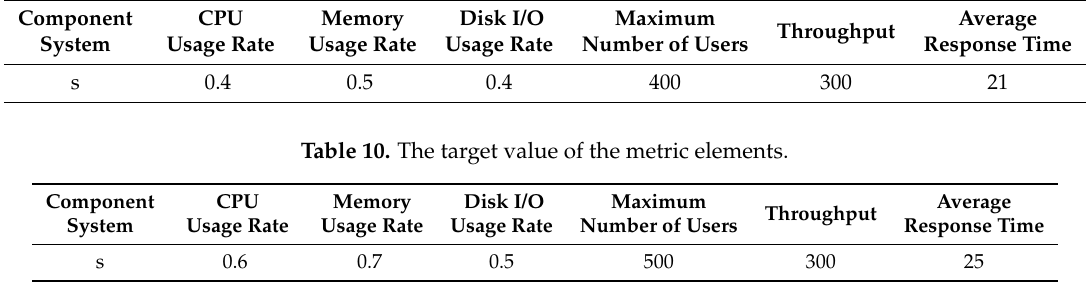
Table 9 is the computational results of performance metrics for component systems. Table 10 shows the target value of the metric element of the component system. Table 9. The computational results of performance metrics for component system.